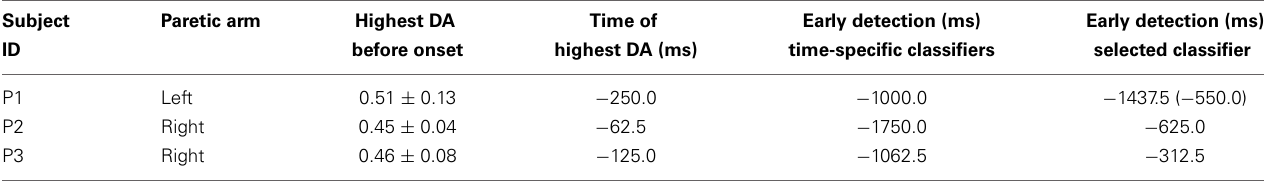
Table 3 | Summary of decoding performances before movement onset for stroke patients, paretic arm.